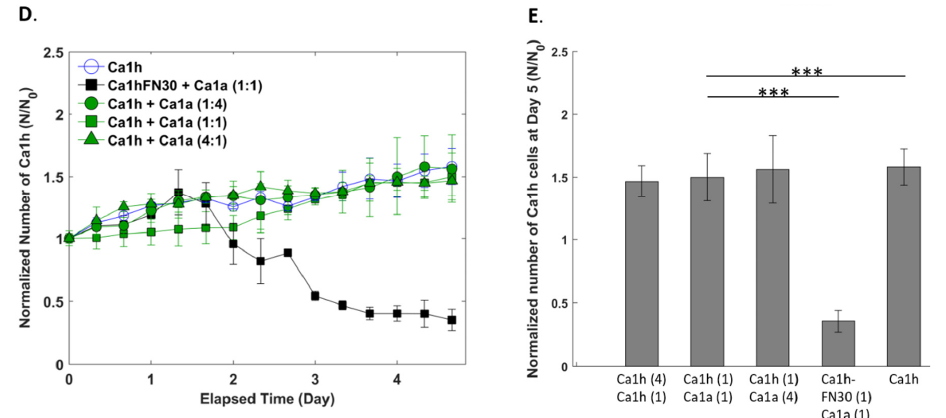
Figure 1. Proliferation of MCF10CA1a (Ca1a) and MCF10CA1h (Ca1h) cells in mono-culture and co-culture within the microfluidic chamber. ( A ) Wide-field 4× objective fluorescent microscopy images of the mono-cultured and co-cultured Ca1a cells. The scale bar shows 100 µm. ( B ) Normalized number of Ca1a cells across culture conditions and ( C ) at the terminal time point. ( D ) Normalized number of Ca1h cells across culture conditions and ( E ) at the terminal time point. p -values are denoted with asterisks (*) as follows: *: significant at p < 0.05, and ***: significant at p < 0.001. Cancers 2020 , 12 , x